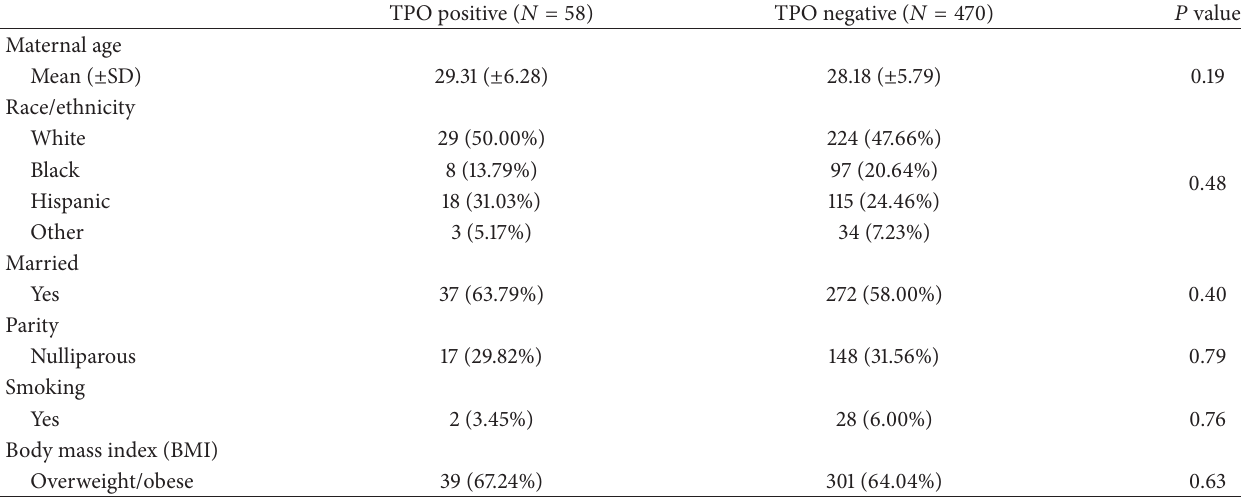
Table 1: Selected sociodemographic characteristics by TPO status of pregnant women in the study.